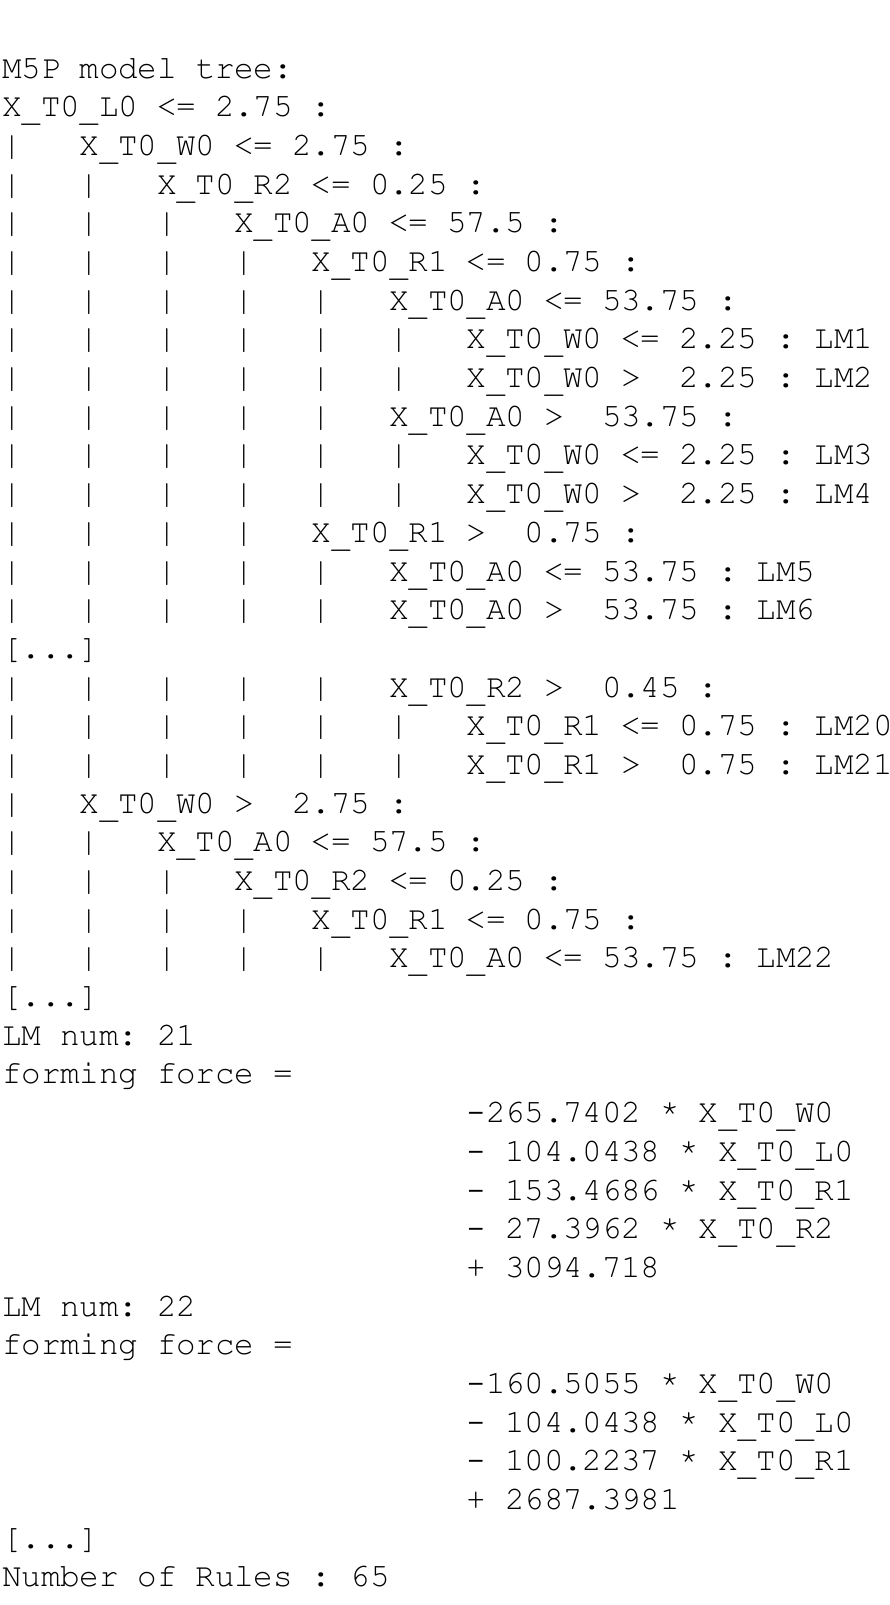
Figure 6. Excerpt of the M5P regression tree, which was found to be the most reliable metamodel in this use case. [...] marks skips of the complete text-based model which is about 660